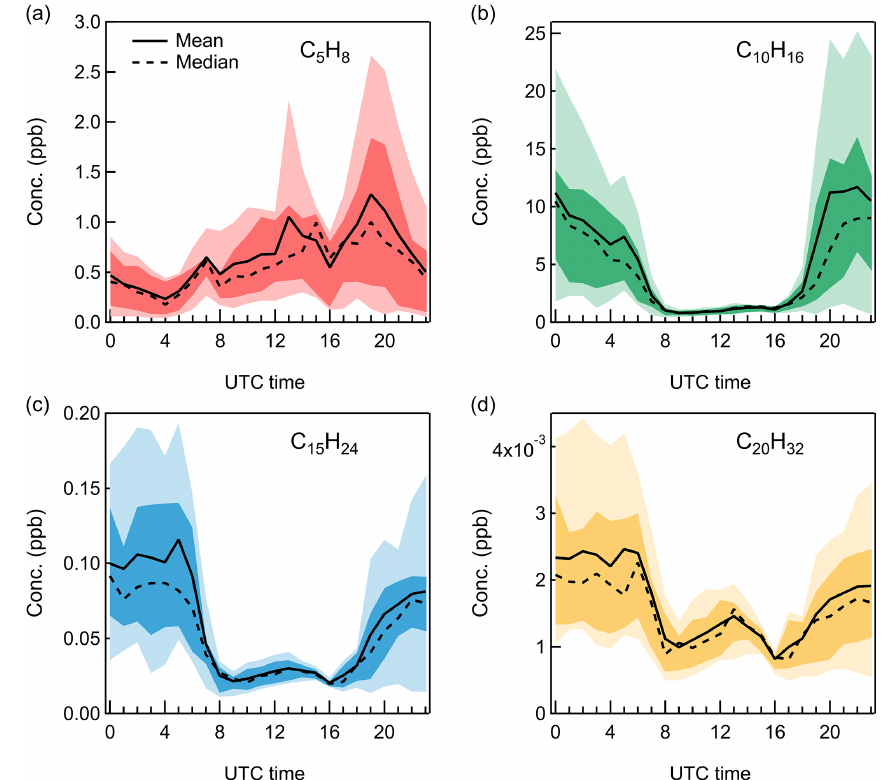
Figure 4. Diurnal cycles of (a) C 5 H 8 , (b) C 10 H 16 , (c) C 15 H 24 , and (d) C 20 H 32 , with the 10th, 25th, 75th, and 90th percentiles shown in the shaded area.